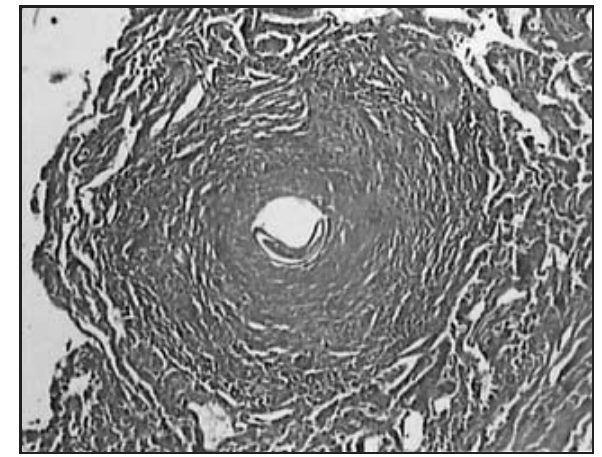
Figura 1 – Radiografia do tórax mostrando infiltrado micronodular difuso